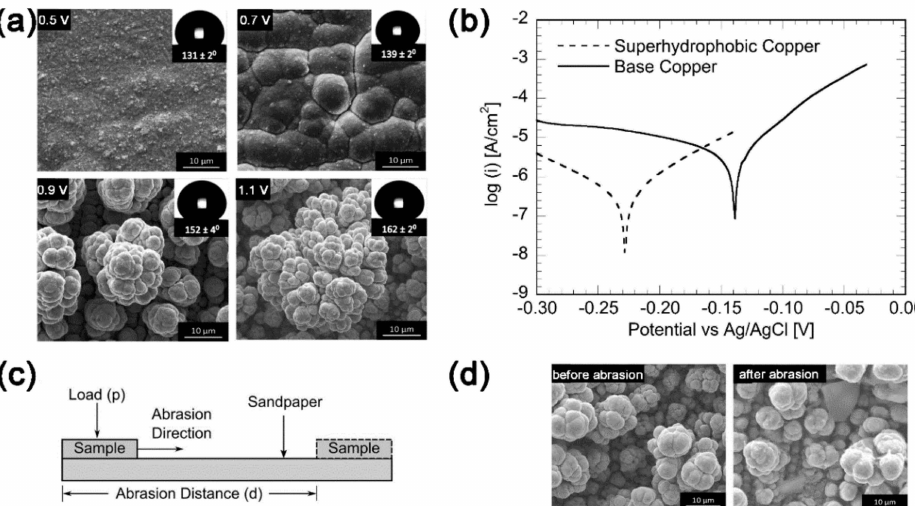
Figure 15. ( a ) SEM morphologies and WCAs of electrodeposited Cu fabricated at overpotentials of 0.5 V, 0.7 V, 0.9 V, and 1.1 V; ( b ) Potentiodynamic polarization curves for super-hydrophobic and base Cu in 3.5 wt % NaCl solution; ( c ) Schematic of the shear abrasion test setup; ( d ) SEM morphologies of super-hydrophobic sample before and after abrasion test. Reprinted (adapted) with permission from [84]. Copyright (2018) American Chemical